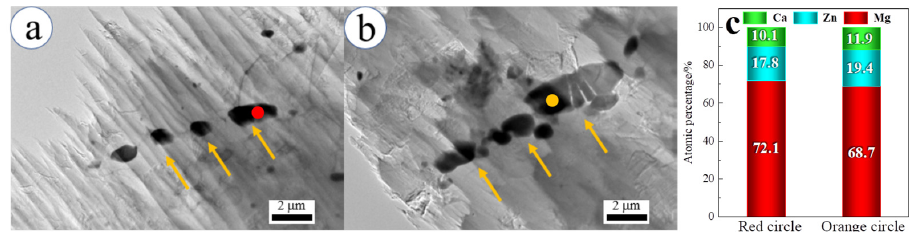
Figure 4. TEM images for the Ca 2 Mg 6 Zn 3 phase in the Mg-3Zn-0.2Ca alloy and 1 β -TCP/Mg-3Zn-0.2Ca composite: ( a ) A-6 P-593 K, ( b ) C-6 P-593 K; ( c ) EDS point analysis results derived from red solid circle in ( a ) and orange solid circle in ( b ) (Orange arrows refers to the Ca 2 Mg 6 Zn 3 s phases).